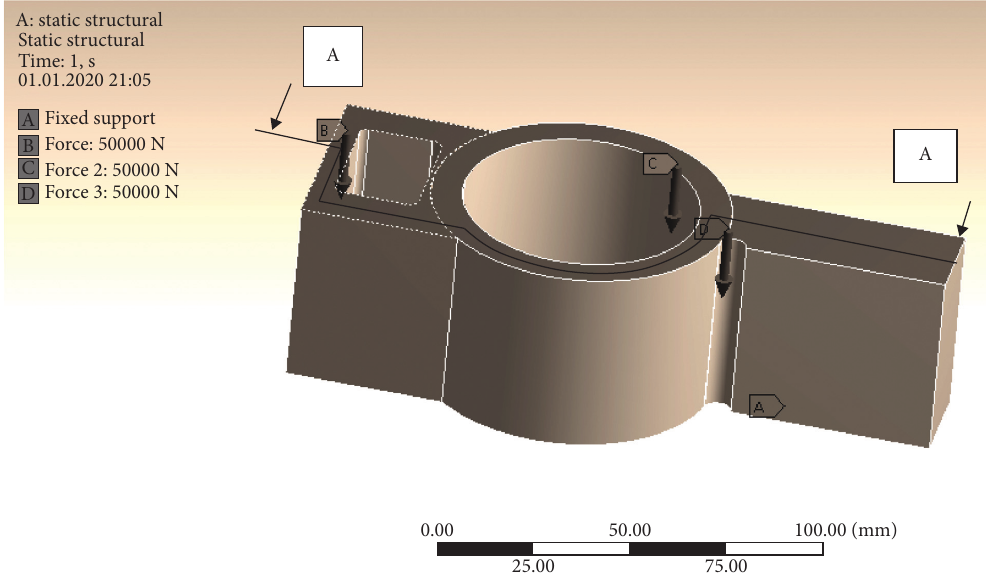
Figure 7: Fixed surface and applied forces for the finite element method to section A-A.